Question: How would you classify this visualization?
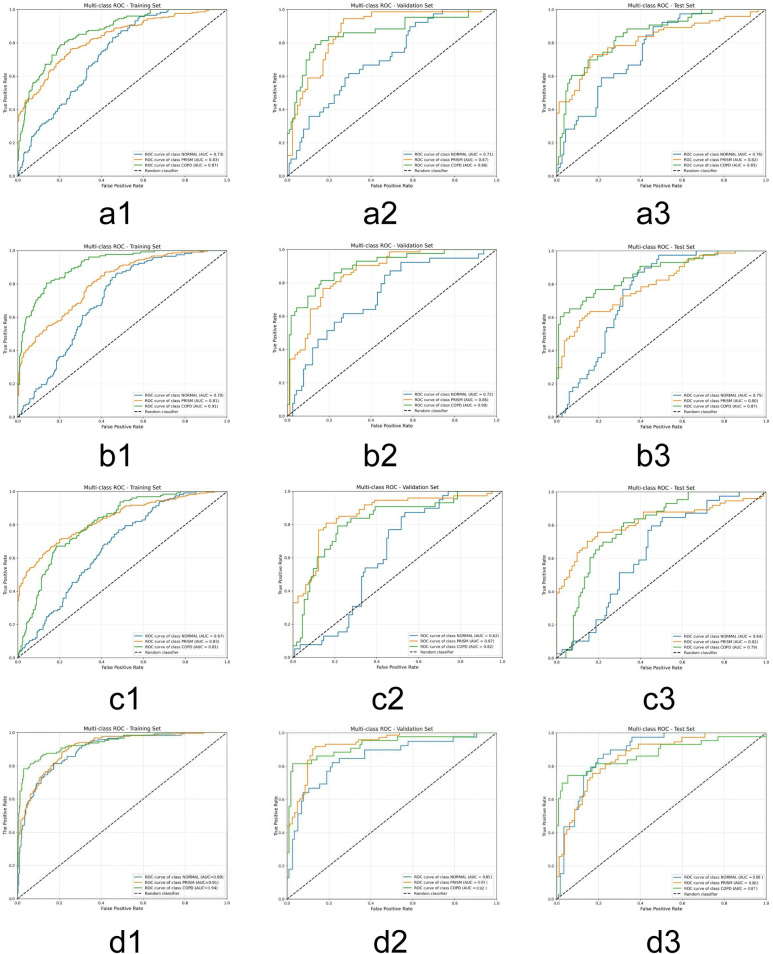
Answer: line